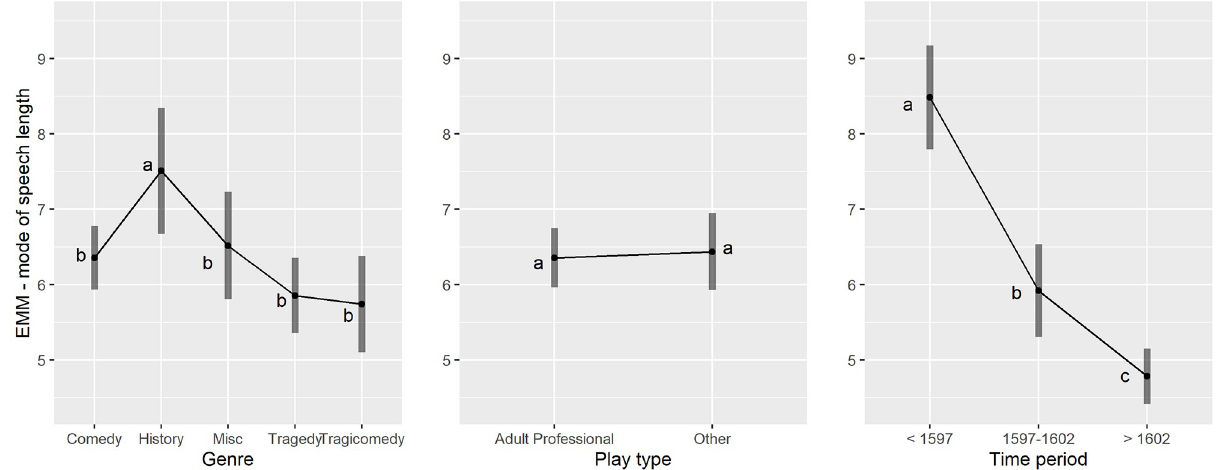
Fig 9. (S1 Fig 10 in S1 File) Mode of speech length: EMMs and 95% Confidence Intervals from the final LMM model with main effects for the three explanatory variables of genre, play type and time period. Within each plot letters have been added to show which levels are statistically different, categories with different letters are different, letters the same not different.